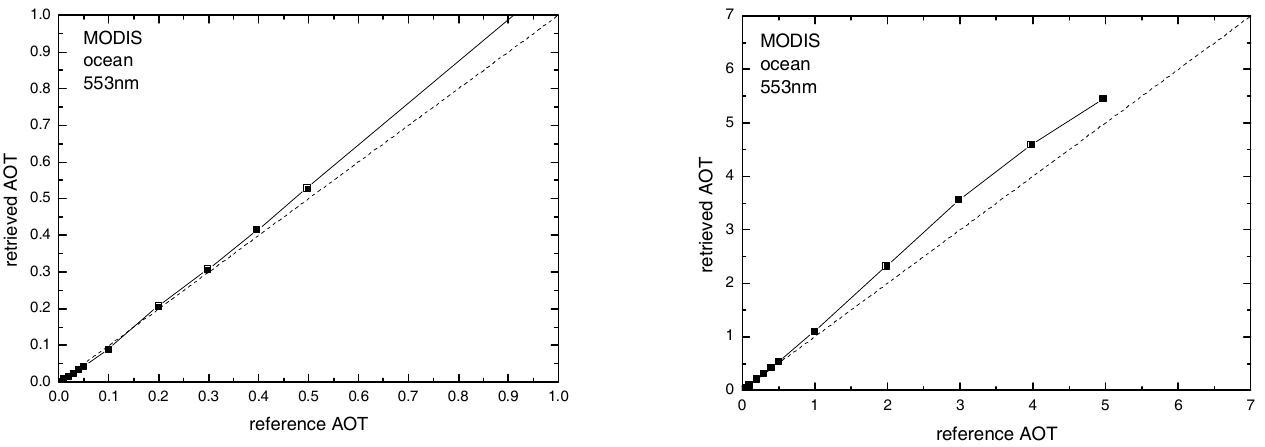
Fig. 10. The same as in Fig. 9a, b except the NASA MODIS over ocean satellite aerosol retrieval algorithm was used.